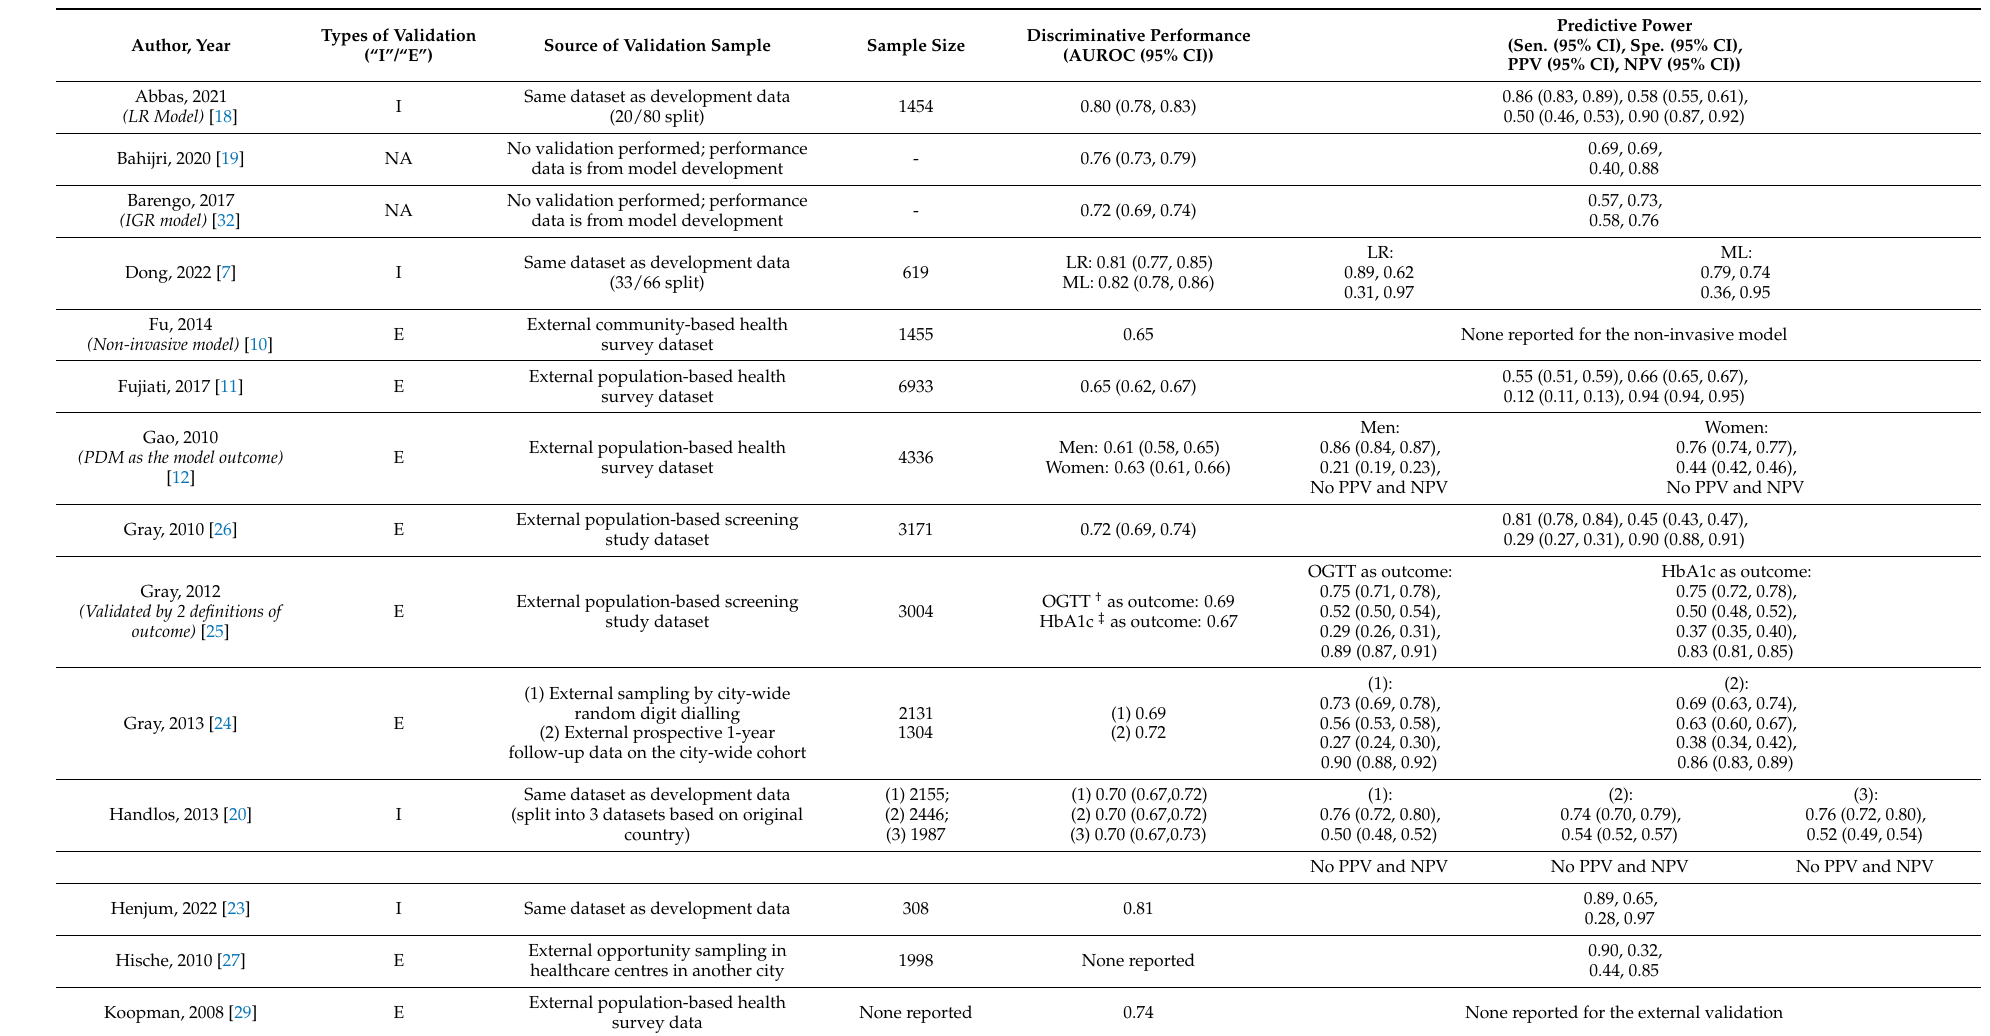
Table 2. Summary of validation performance of the pre-DM prediction tools reported by the included studies ( n =